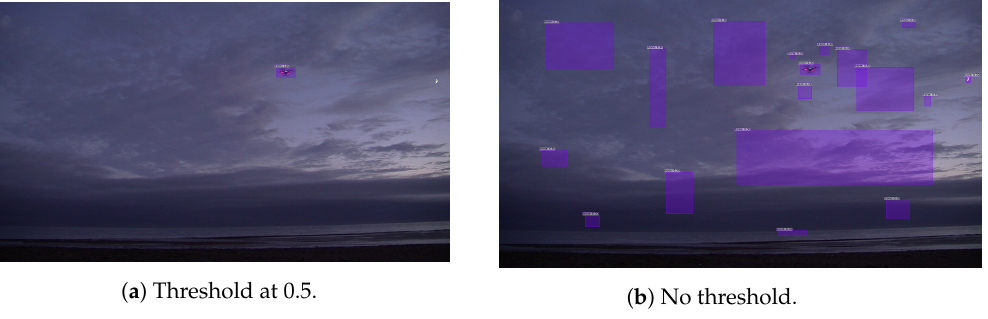
Figure 8. Comparison between different thresholds under same image.